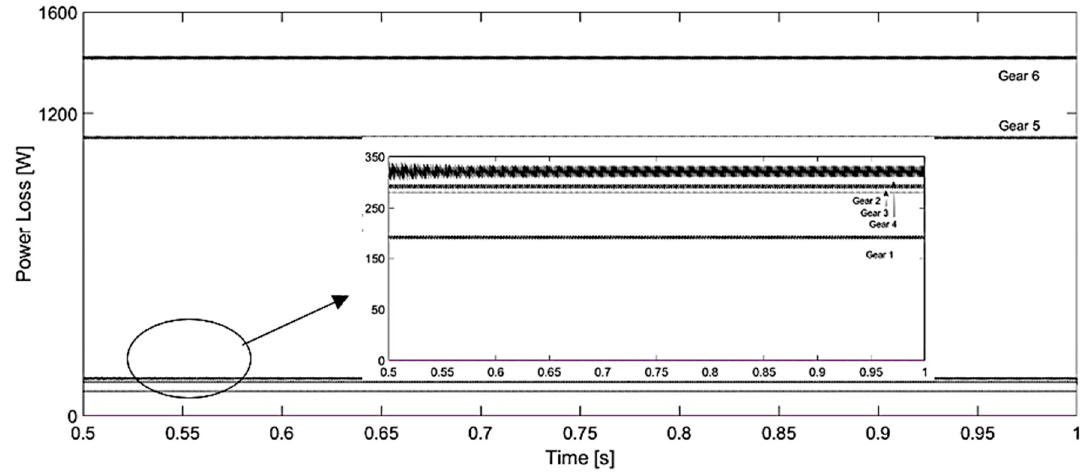
Figure 11. Power losses for DLC-coated gears, scenario 1.